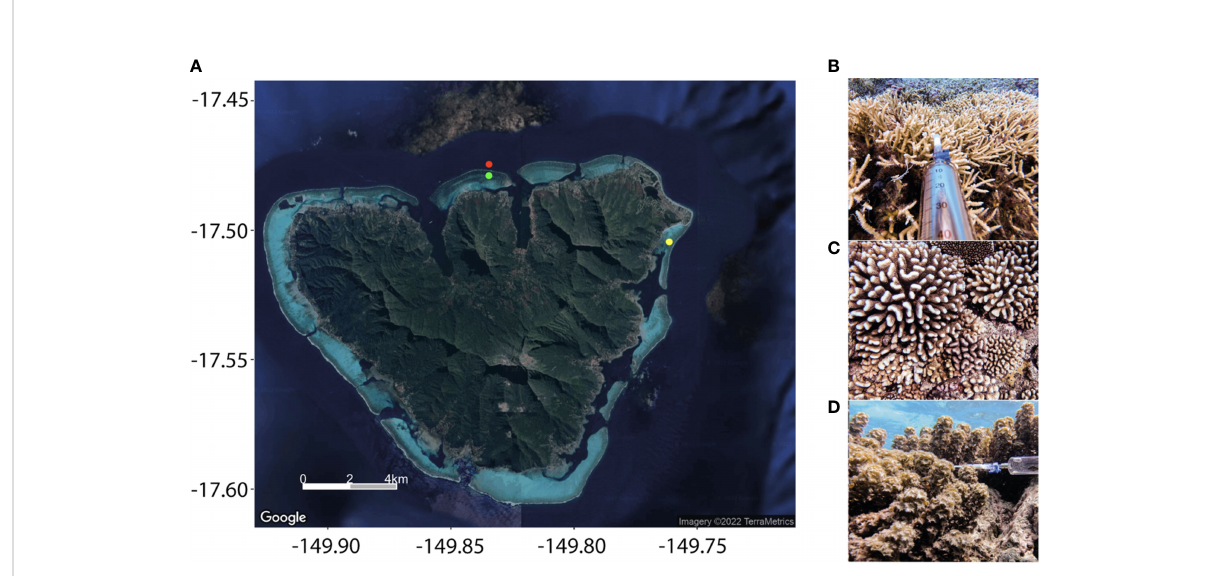
FIGURE 1 (A) Location of the sampling sites in Mo ’ orea. Zoom into the fore reef and back reef sampling sites in the northern coast, off Cook ’ s Bay, and into the back reef sampling site in the Tema ’ e Beach reef, along the northwestern coast, where the diel study was conducted. Images of (B) Acropora pulchra , (C) Pocillopora sp., and (D) Turbinaria ornata , with the all-glass syringe used to collect